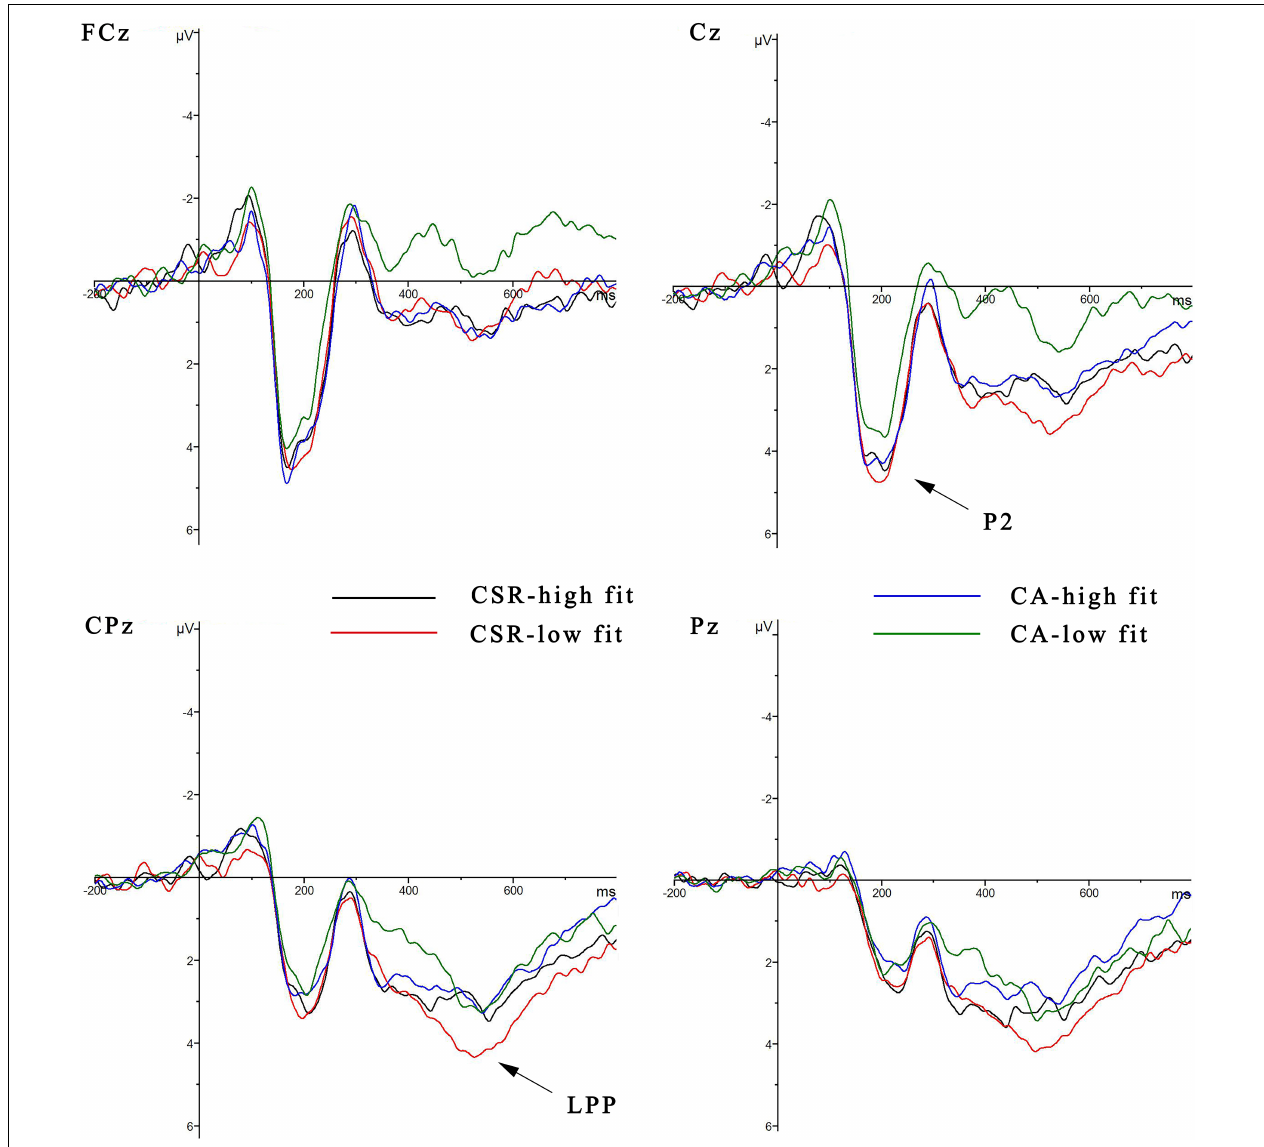
FIGURE 3 | Grand averaged ERPs of P2 and LPP for brand reputation and perceived fit at midline electrodes (FCz, Cz, CPz, and